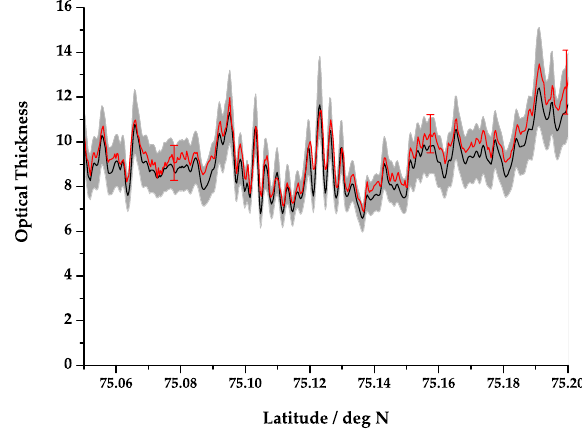
Fig. 12. Histogram of the cloud optical thickness retrieved from ra- diances measured by the AisaEAGLE in all spatial pixels (red) and in the nadir (ES) pixels (gray), compared to the optical thickness re- trieved from nadir radiances measured by the SMART-Albedometer (5WL algorithm in blue, 2WL in black).